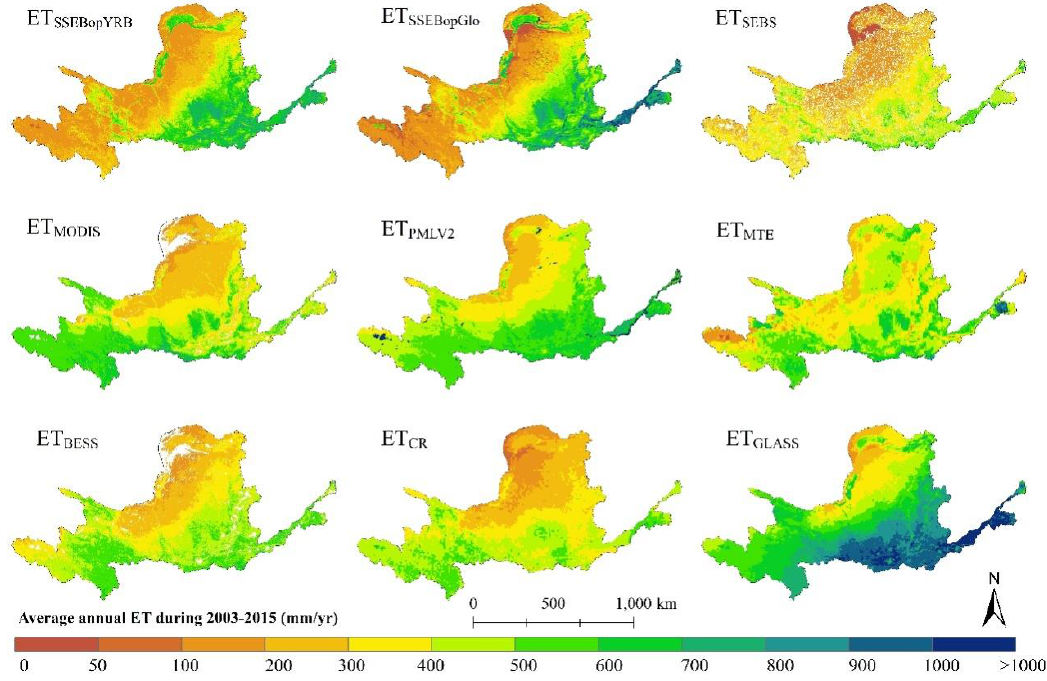
Figure 4. Spatial patterns of the average annual ET comparisons between ET SSEBopYRB and other ET products in the YRB during the years 2003–2015. The white areas represent missing values for the corresponding ET product.